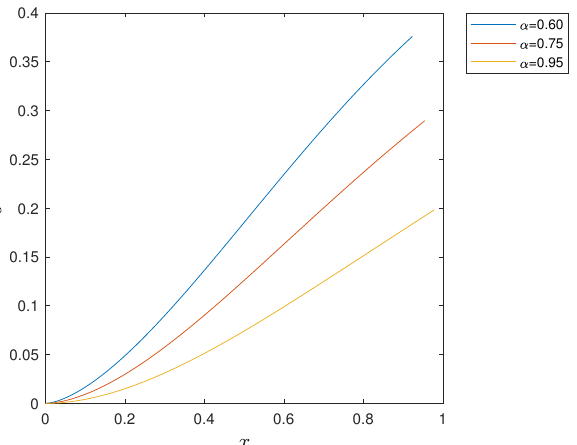
Figure 3. Deflection shapes of a cantilever beam under a uniformly distributed load P = 0.73 at the equilibrium position for α = 0.6,0.75, and